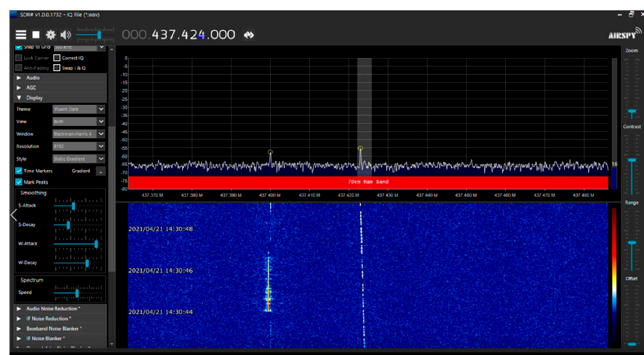
Figure 16. CW signal received on the ground.